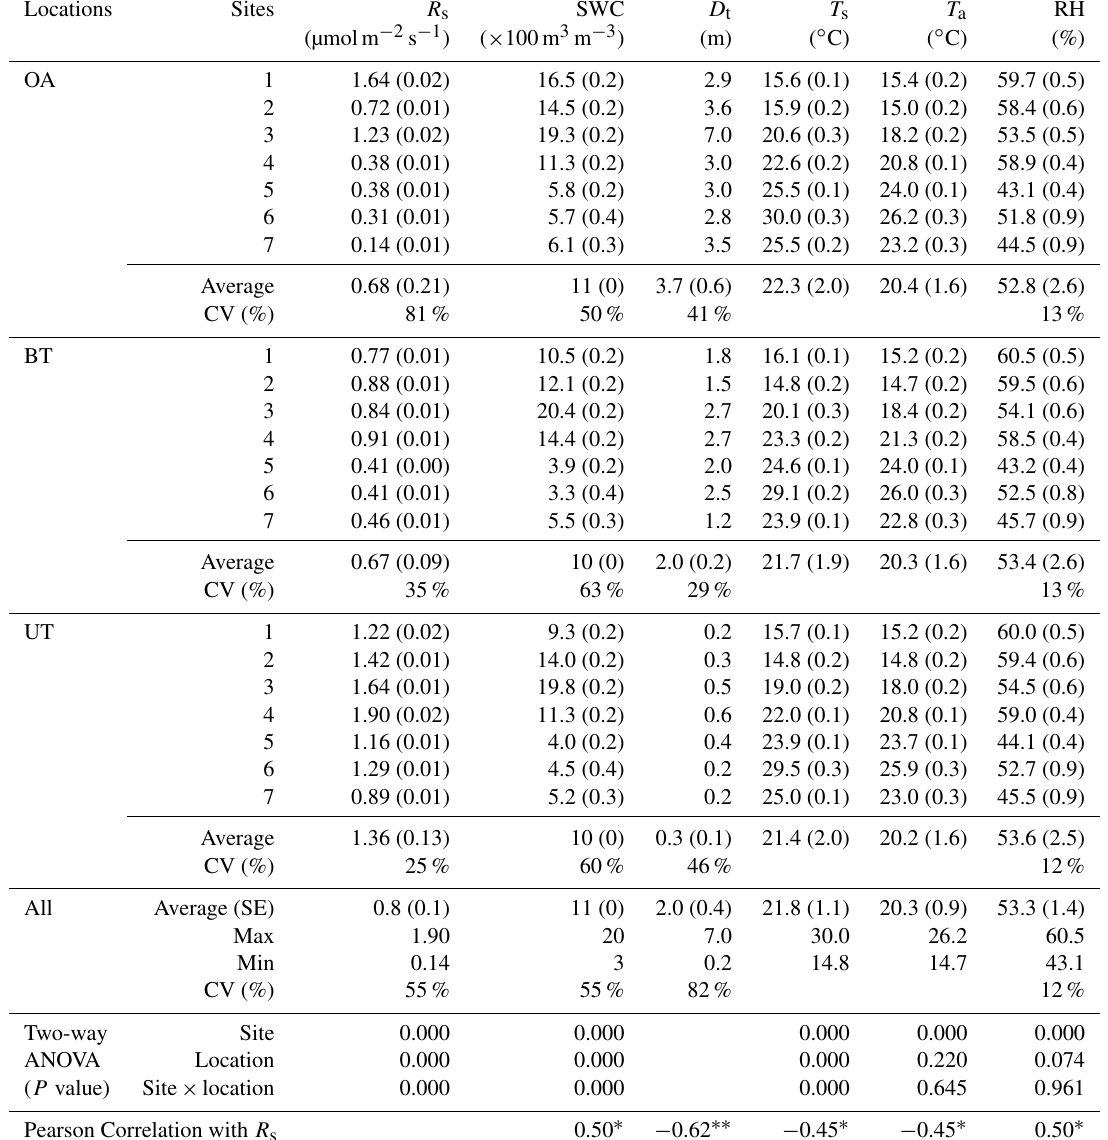
Table 1. Annual mean of half-hourly values across locations (OA, open area; BT, between trees; UT, under tree) in seven sites in the forest during the study period of soil respiration flux rates ( R s ) together with the soil water content at 10cm depth (SWC), minimum distances from nearby tree ( D t ), soil temperature at 5cm depth ( T s ), and air temperature ( T a ) and relative humidity (RH) at the soil surface (numbers in parentheses indicate ±